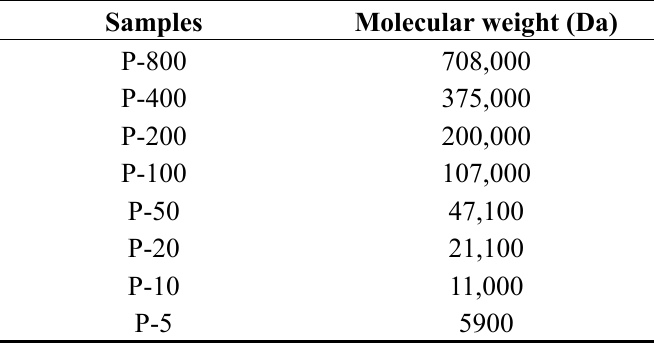
Table 2. Molecular weight of pullulan